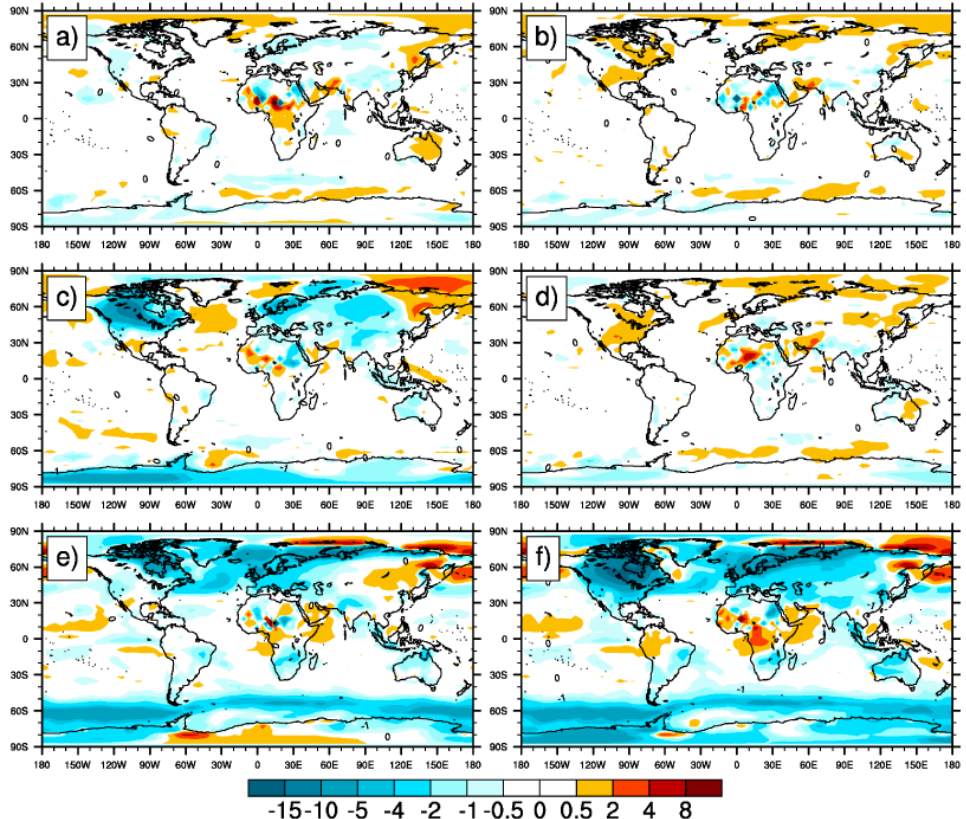
Fig. 9. The anomalies of δ 18 O precip (‰) for (a) GHG, (b) albedo, (c) topography, (d) orbital, (e) SST, and (f) LGM-combined experiments from the control experiment for the boreal winter